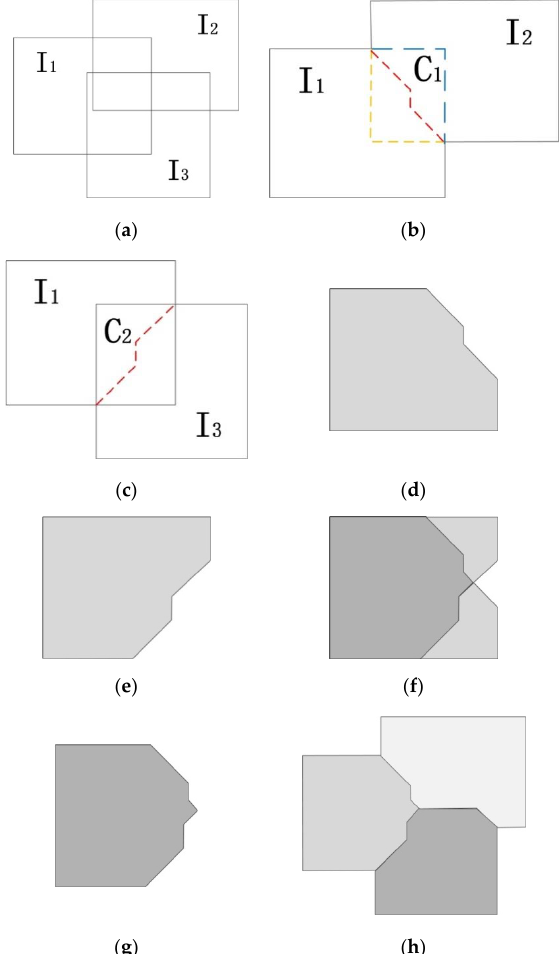
Figure 3. The illustration of EMP determination: ( a ) the arrangement of images according geocoding; ( b ) the generated seamline of C 1 ; ( c ) the generated seamline of C 2 ; ( d ) the result of cutting image I 1 by C 1 ; ( e ) the result of cutting image I 1 by C 2 ; ( f ) the arrangement of the two cut results for image I 1 ; ( g ) the EMP of image I 1 ; ( h ) EMPs of image I 1 , image I 2 , and image I 3 .